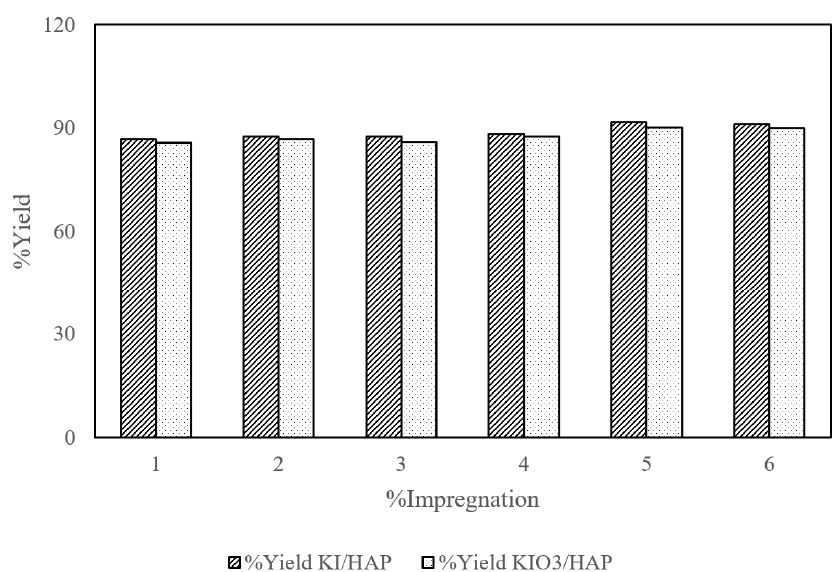
Figure 8. E ff ect of catalyst type to % yield of